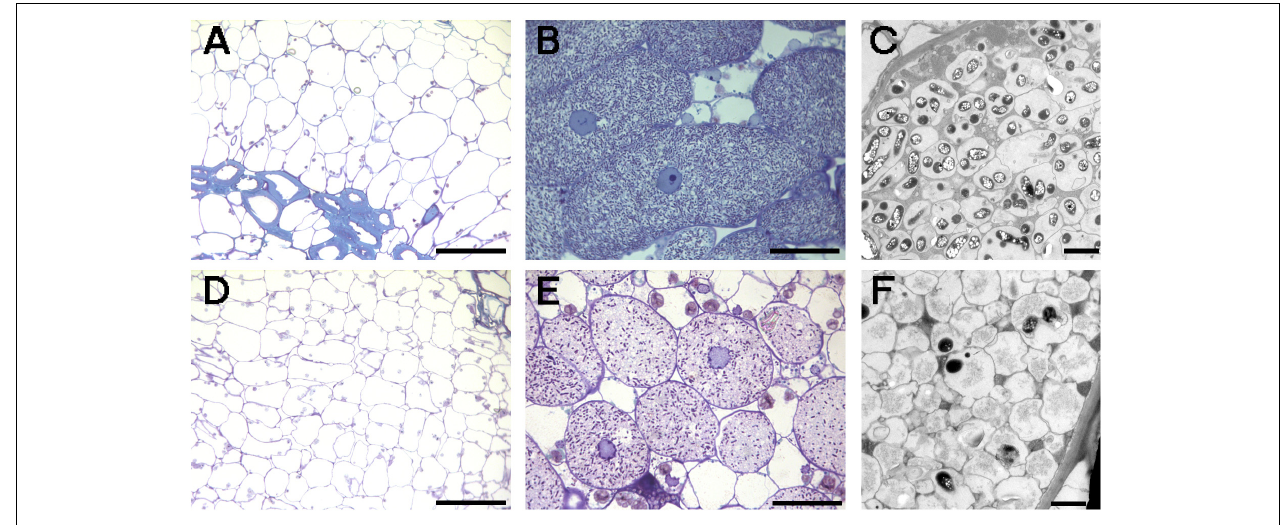
FIGURE 5 | Optical (A,B,D,E) and electronic (C,F) microscopy of nodules induced by different S. fredii strains in soybean cv. Williams 82. (A) NGR234; (B,C) HH103 Rif R ; (D) USDA193C pSymNGR234M; (E,F) NGR234C pSymHH103M. Bars correspond to 100 µ m in (A,D) , 30 µ m in (B,E) , and 2 µ m in (C,F) .